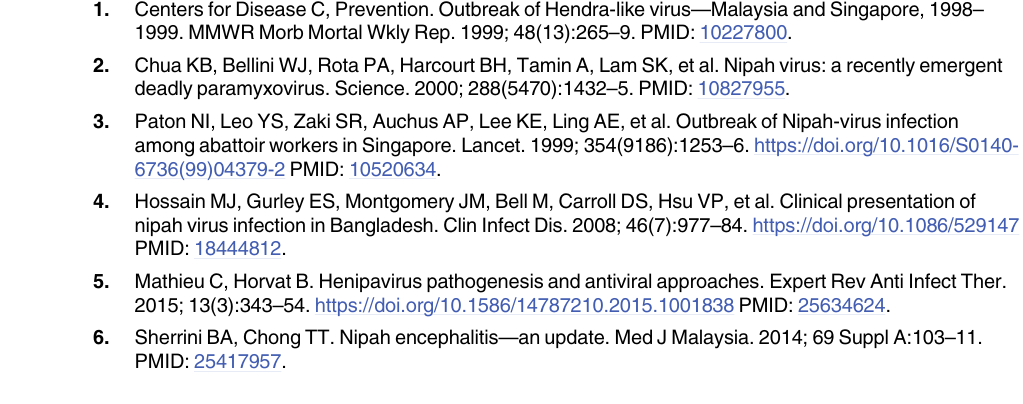
S3 Table. Antibody panel used for flow cytometry study in the lung, brain and BAL. Table provides the target marker, antibody clone used and the fluorophore conjugated to each individual antibody. The polyclonal antisera used for detecting NiV G protein was developed in rabbit inoculated with purified NiV G